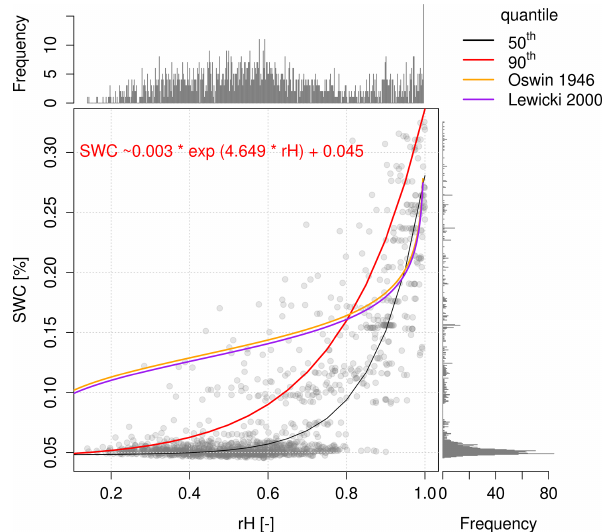
Figure H1. Relationship of SWC and rH during modeled adsorp- tion (gradient-driven vapor diffusion towards the soil surface) from April to October. The full formula with the parameters for the 90th quantile from nonlinear quantile regression is given in the up- per left. The black line additionally illustrates the 50th quantile. Em- pirical relationships from the literature for equilibrated conditions are shown in orange and purple (Oswin, 1946; Lewicki,